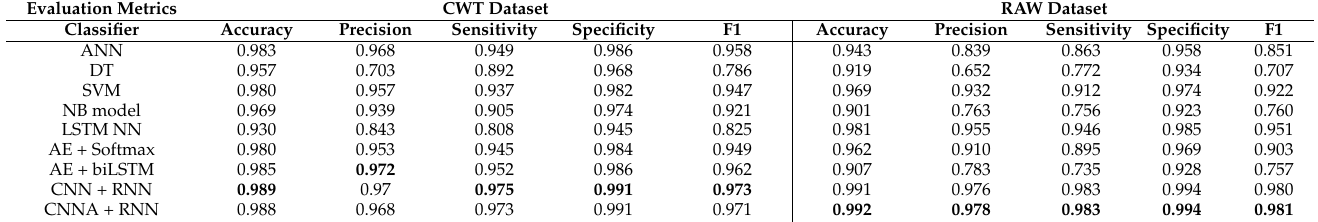
Table 4. Averaged cross-validated evaluation metrics for the corresponding nine classifiers.